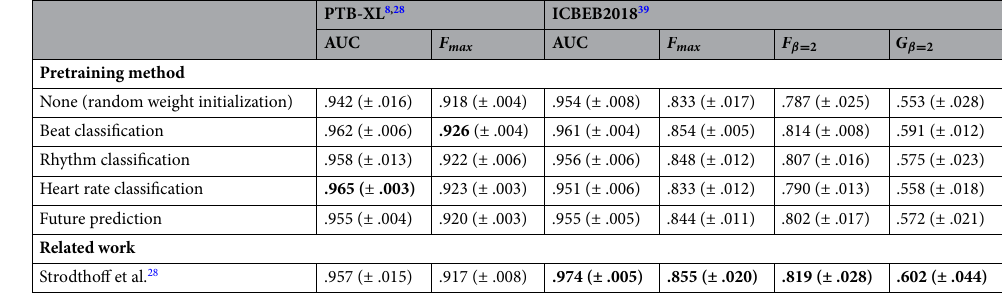
Table 5. Comparison of the pretraining methods on two new downstream data sets. For each method, we report the average performance (and the standard deviation) on the respective test sets. We observe performance improvements from pretraining on both data sets. Bold numbers in ICBEB2018 dataset reflect the best overall performance (i.e. that of Strodthoff et al. 28 ), instead of the best pretraining performance (i.e. Beat